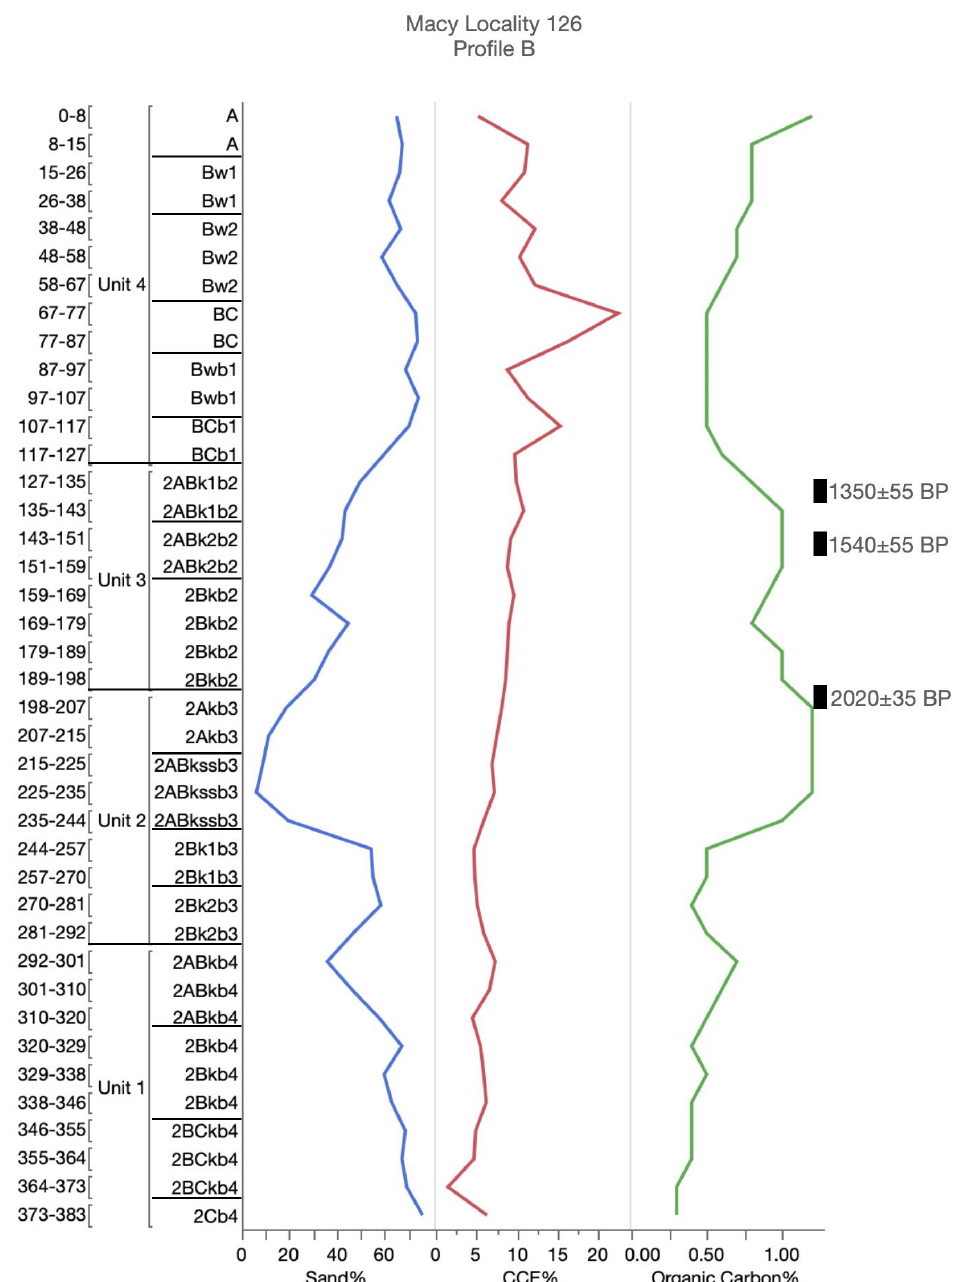
Figure A7. Accepted radiocarbon ages and soil and sediment analysis at Macy Locality 126, Profile B — Post research area, northwest, Texas. CCE = calcium carbonate equivalence.